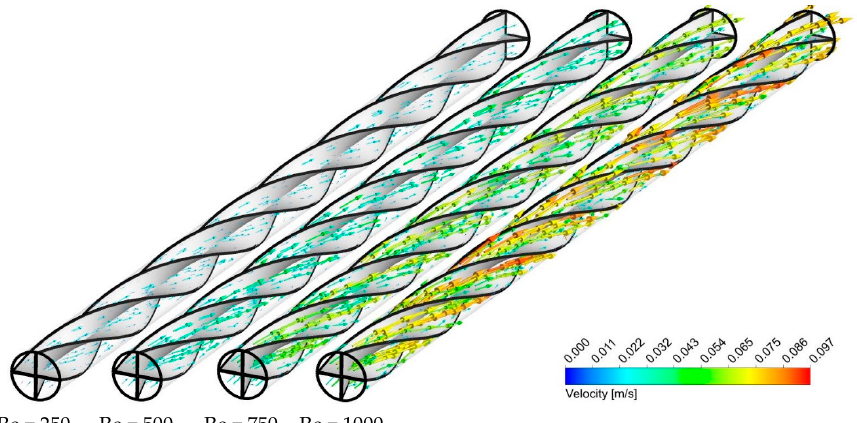
Figure 13. Velocity vector for Case 5 at different Re numbers and ϕ = 0%.